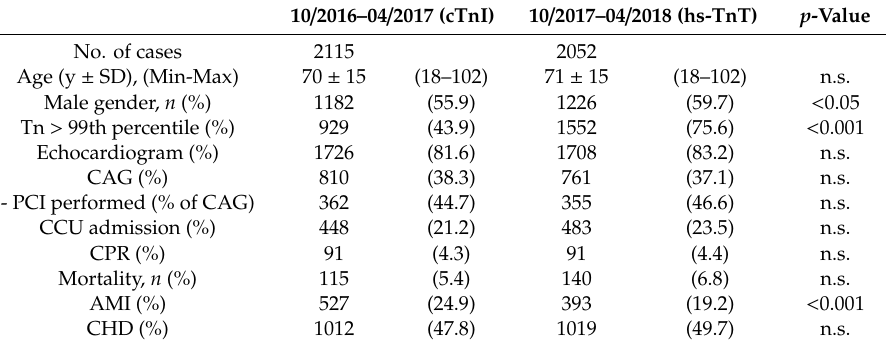
Table 2. Demographic and hospital data for all inpatients of the cardiology department (Subgroup